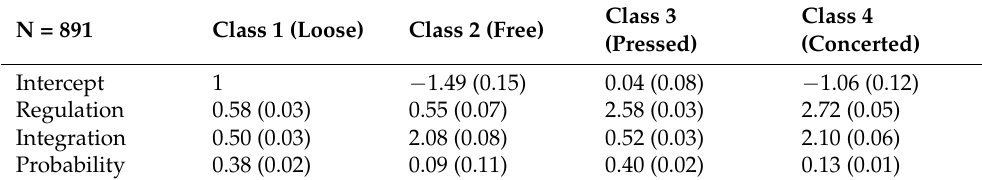
Table 4. Four-class model by latent class